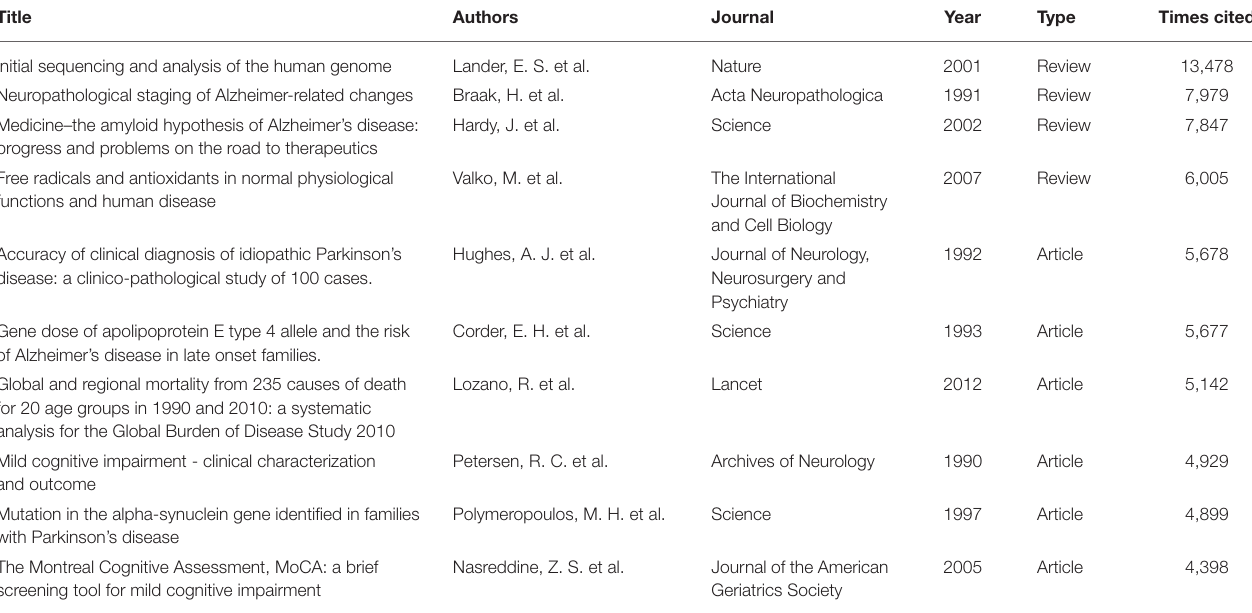
TABLE 1 | The top 10 most frequently cited papers on AD in the